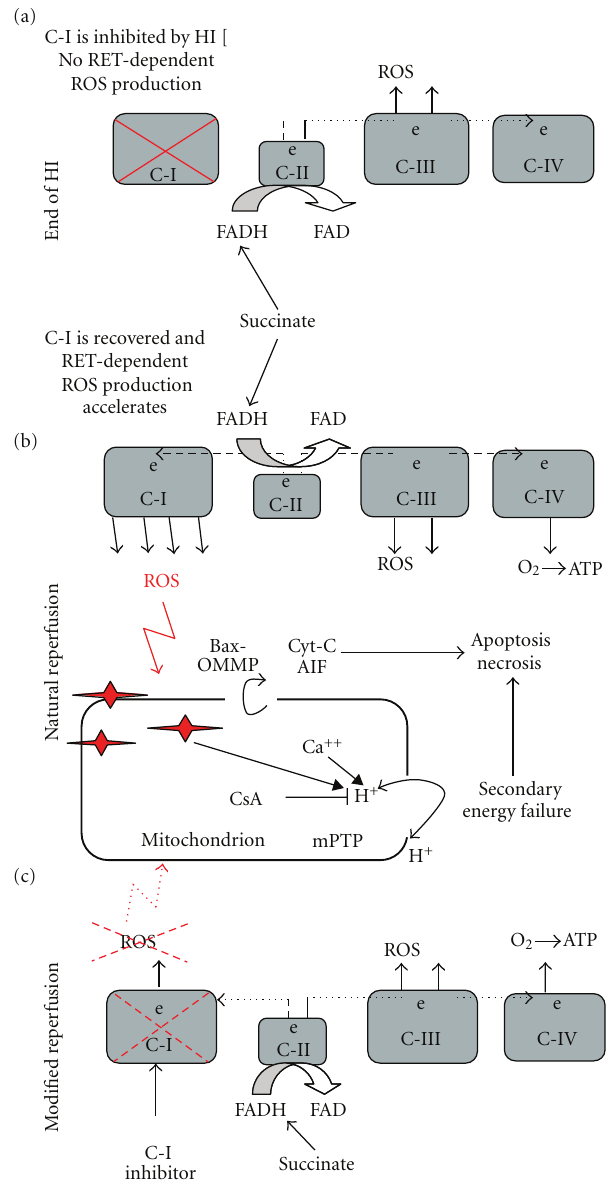
Figure 3: Proposed mechanisms of HI injury targeted by mitochondrial ROS and mechanisms of ROS generation in the MRC at the end of HI insult (a), at the initiation of a natural reperfusion (b), and the reperfusion therapeutically modified by an inhibition of the reperfusion- driven complex I recovery (c). Arrows indicate the leak of cytochrome c and apoptosis inducing factor (AIF), the loss of proton motive force and Ca ++ and ROS contribution to the mPTP opening. CsA is a cyclosporine A which partially inhibits